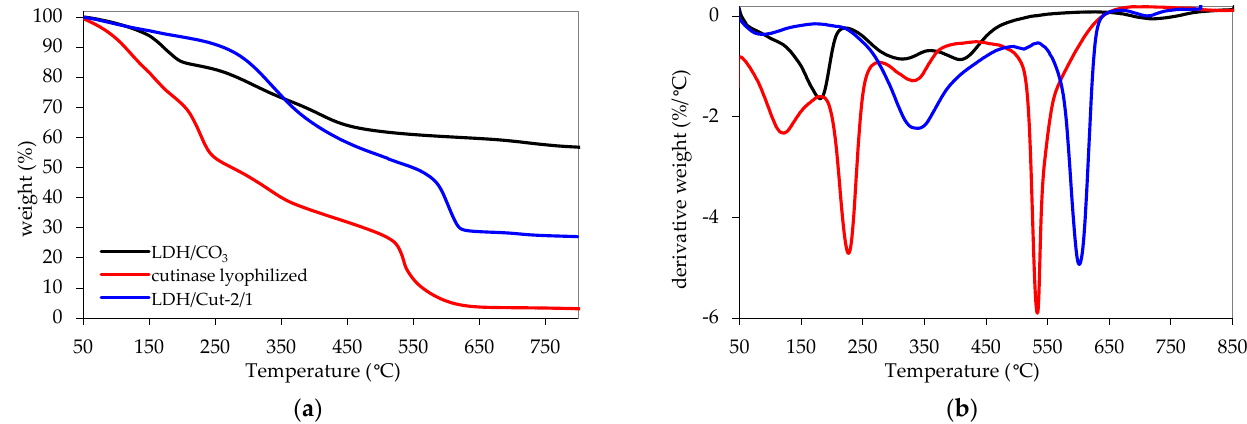
Figure 4. ( a ) TGA and ( b ) dTGA curves of LDH/Cut-2/1, cutinase, and LDH/CO 3 as a reference sample. Table 3. Thermal stability, weight loss step, and corresponding temperature range of samples.